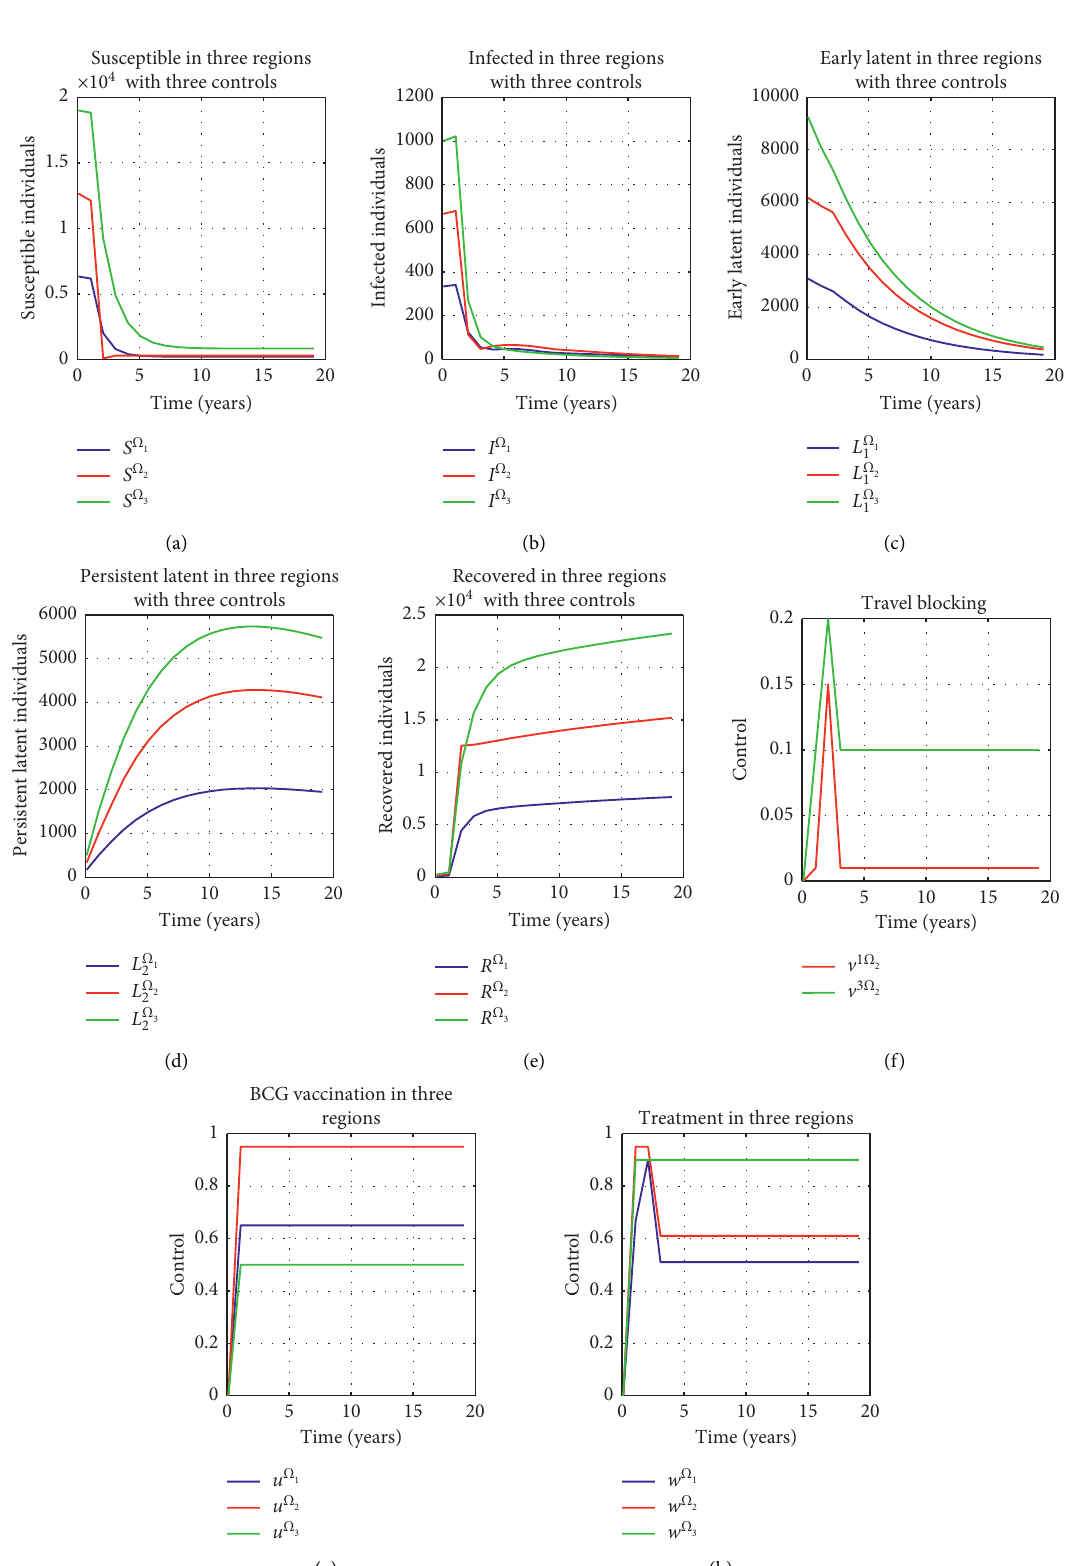
Figure 7: Comparison for each state variable for the three regions with BCG vaccination, travel blocking, and treatment